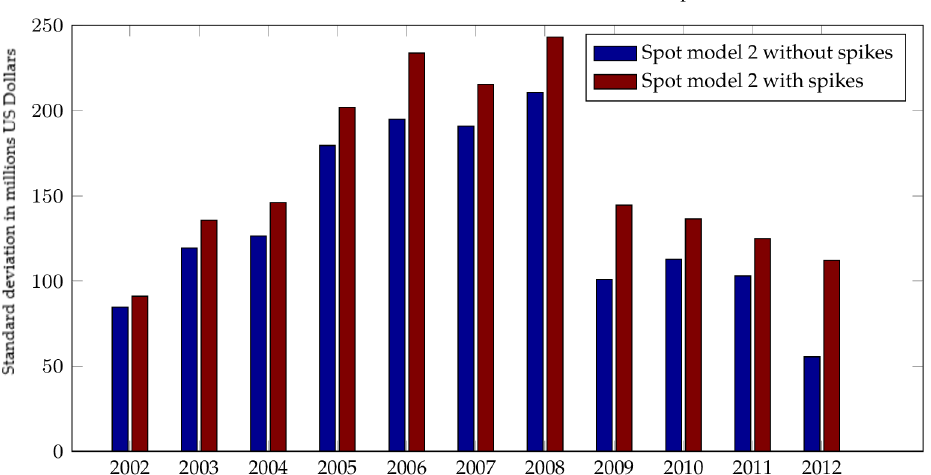
Figure 11. Standard deviation of cash flows on simulated